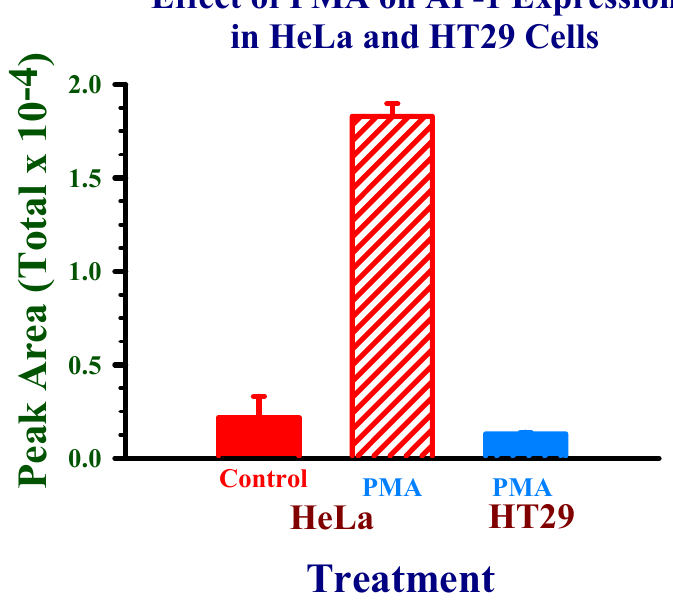
Figure 5. HeLa and HT29 cells were treated with 162 nM 4 β -phorbol 12-myristate 13-acetate (PMA) or DMSO (0.2%) for 4 h to stimulate expression of c-Jun. Nuclear protein extracts from treated